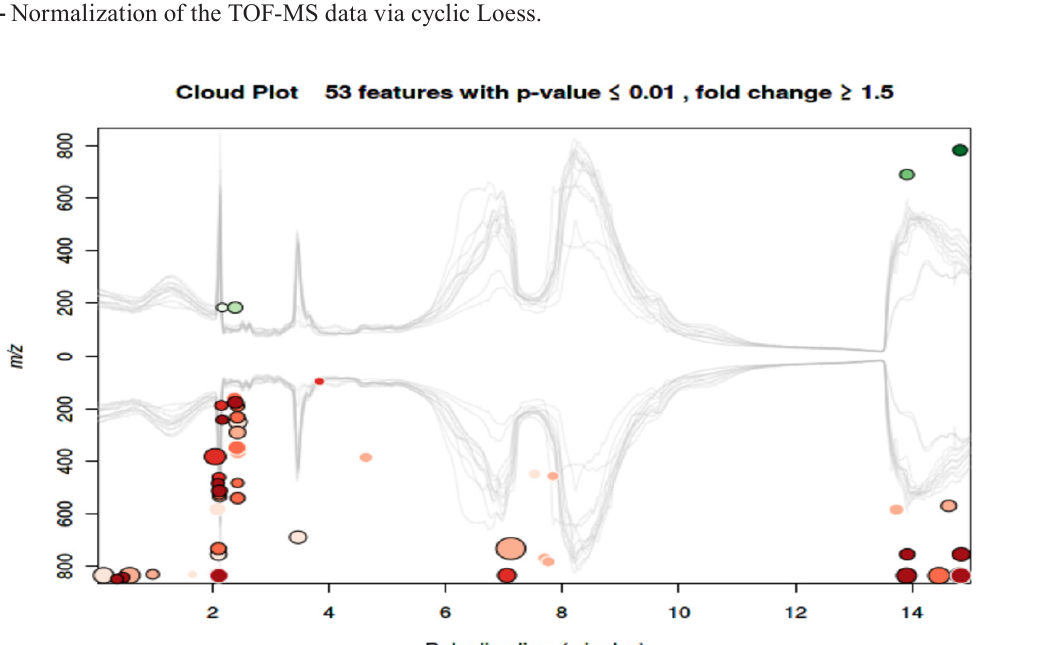
FIGURE 5 - Cloud plot of 53 different metabolites in the drug group compared to the control group (p-value ≤0.01, fold change